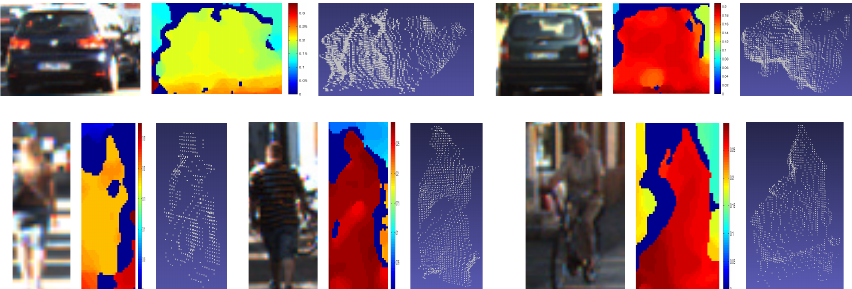
Figure 4. Examples of sparse point clouds manually segmented from the noisy clouds recovered from disparity. Each instance is shown in three representations: the color image patch, the disparity in a color scale and the reprojected 3D point cloud.